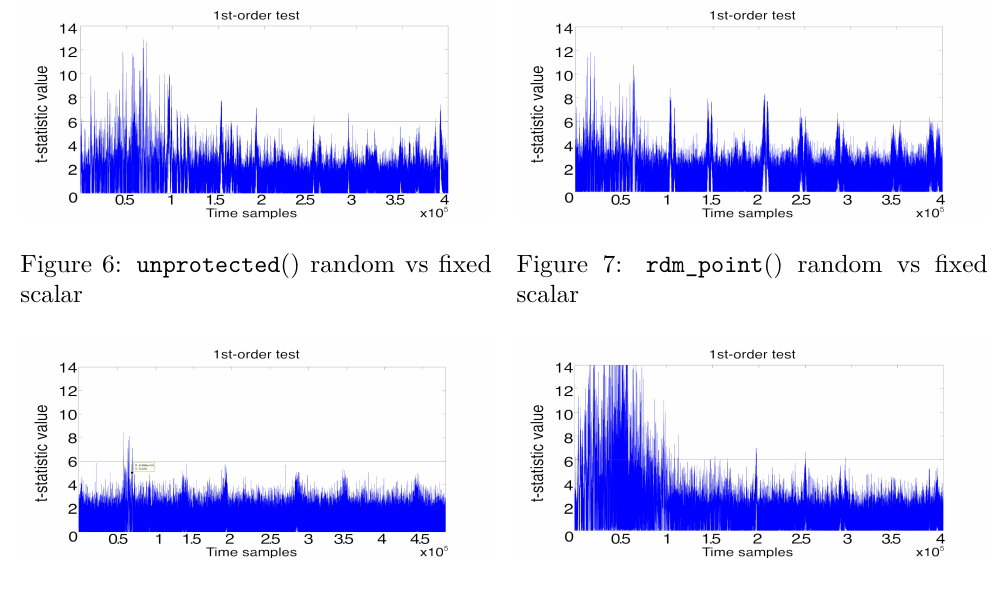
Figure 8: LRA () random vs fixed scalar Figure 9: LRA_rdm_point () random vs fixed